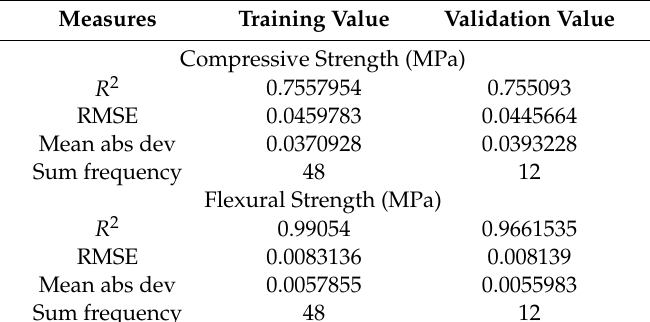
Table 10. Model parameter estimates for training and validation.